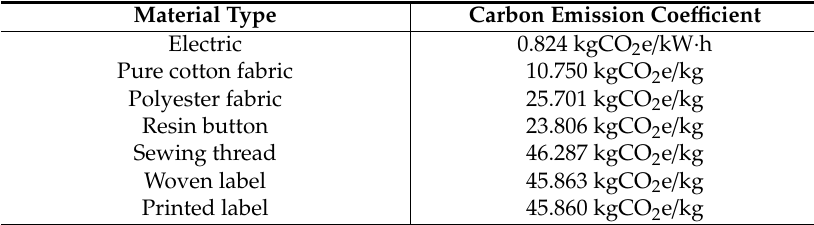
Table 3. Carbon emission coefficients of materials.